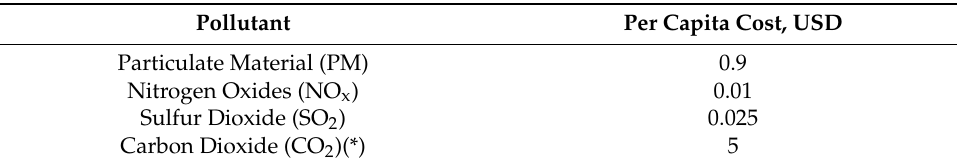
Table 3. Per capita costs of one ton per pollutant. (*) The exception of the tax on CO 2 emissions in the case of fixed sources whose primary energy source is biomass